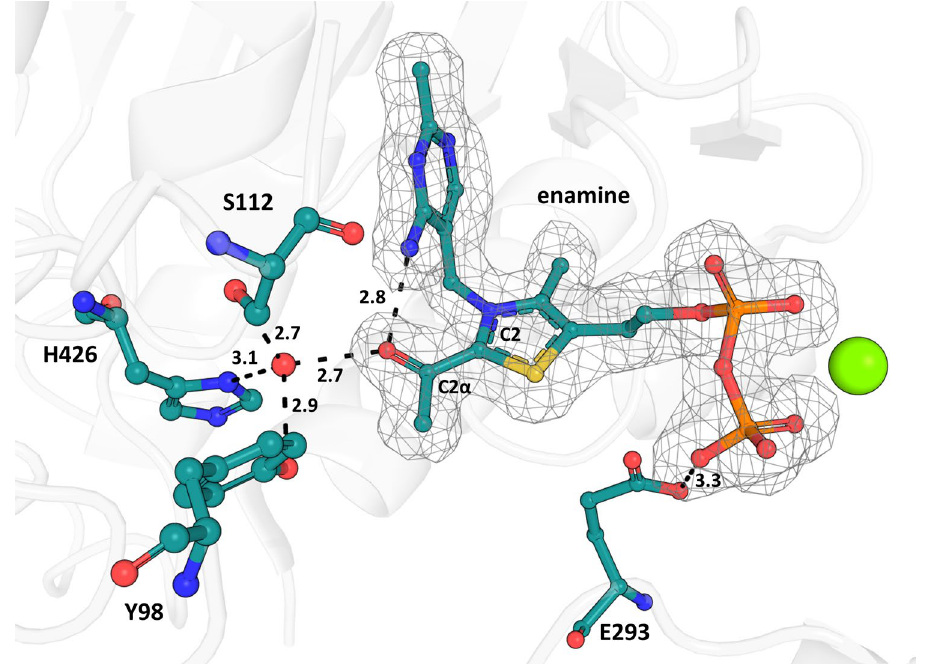
Figure 3. Active site of ∆MtDXPS with enamine-ThDP intermediate. Polder map density contoured at 3σ in gray wire mesh for the enamine-ThDP intermediate (PDB ID: 7A9G ), calculated using Phenix. Key residues involved in the interaction with the enamine are shown and labeled. Distances are indicated in